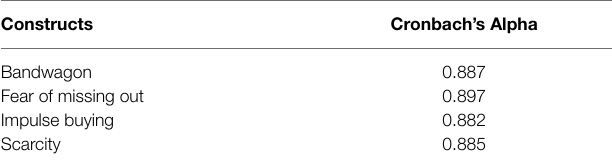
TABLE 2 | Results of the pilot